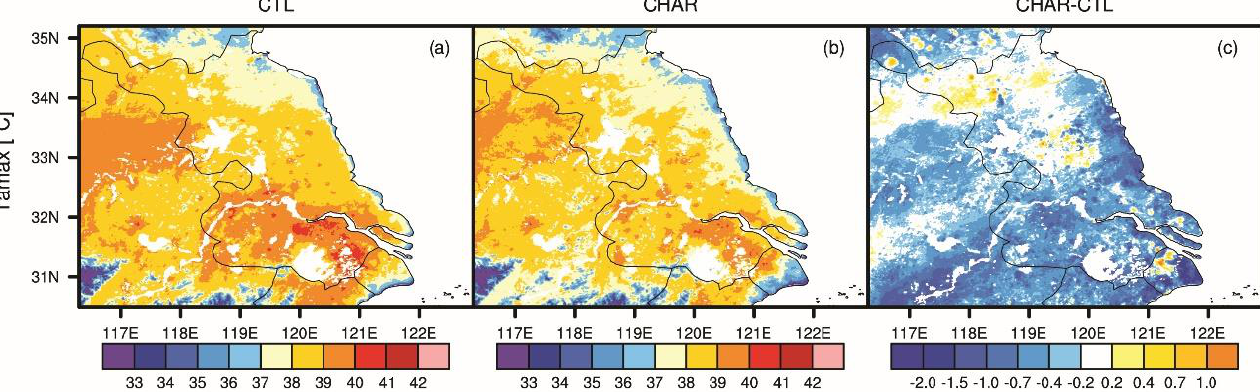
Figure 8. Spatial distribution of mean maximal air temperature (unit: °C) for ( a ) CTL experiment, ( b ) CHAR experiment, and ( c ) their difference over the research period in EC.